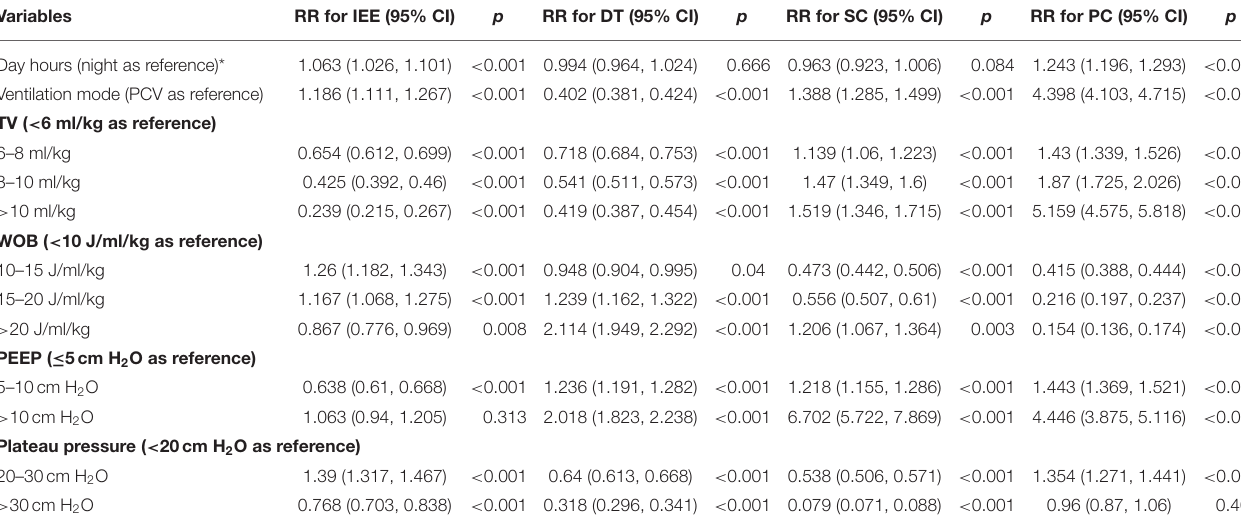
TABLE 4 | Negative binomial regression model exploring the risk factors for the four types of asynchronies. Variables RR for IEE (95%